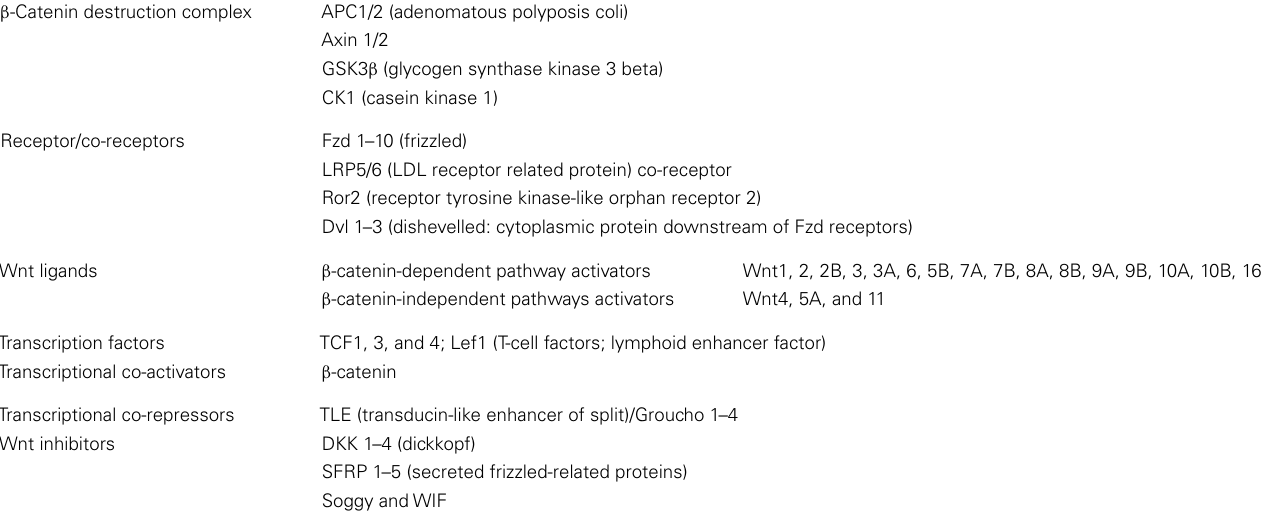
Table 1 | Members of theWnt pathway grouped according to